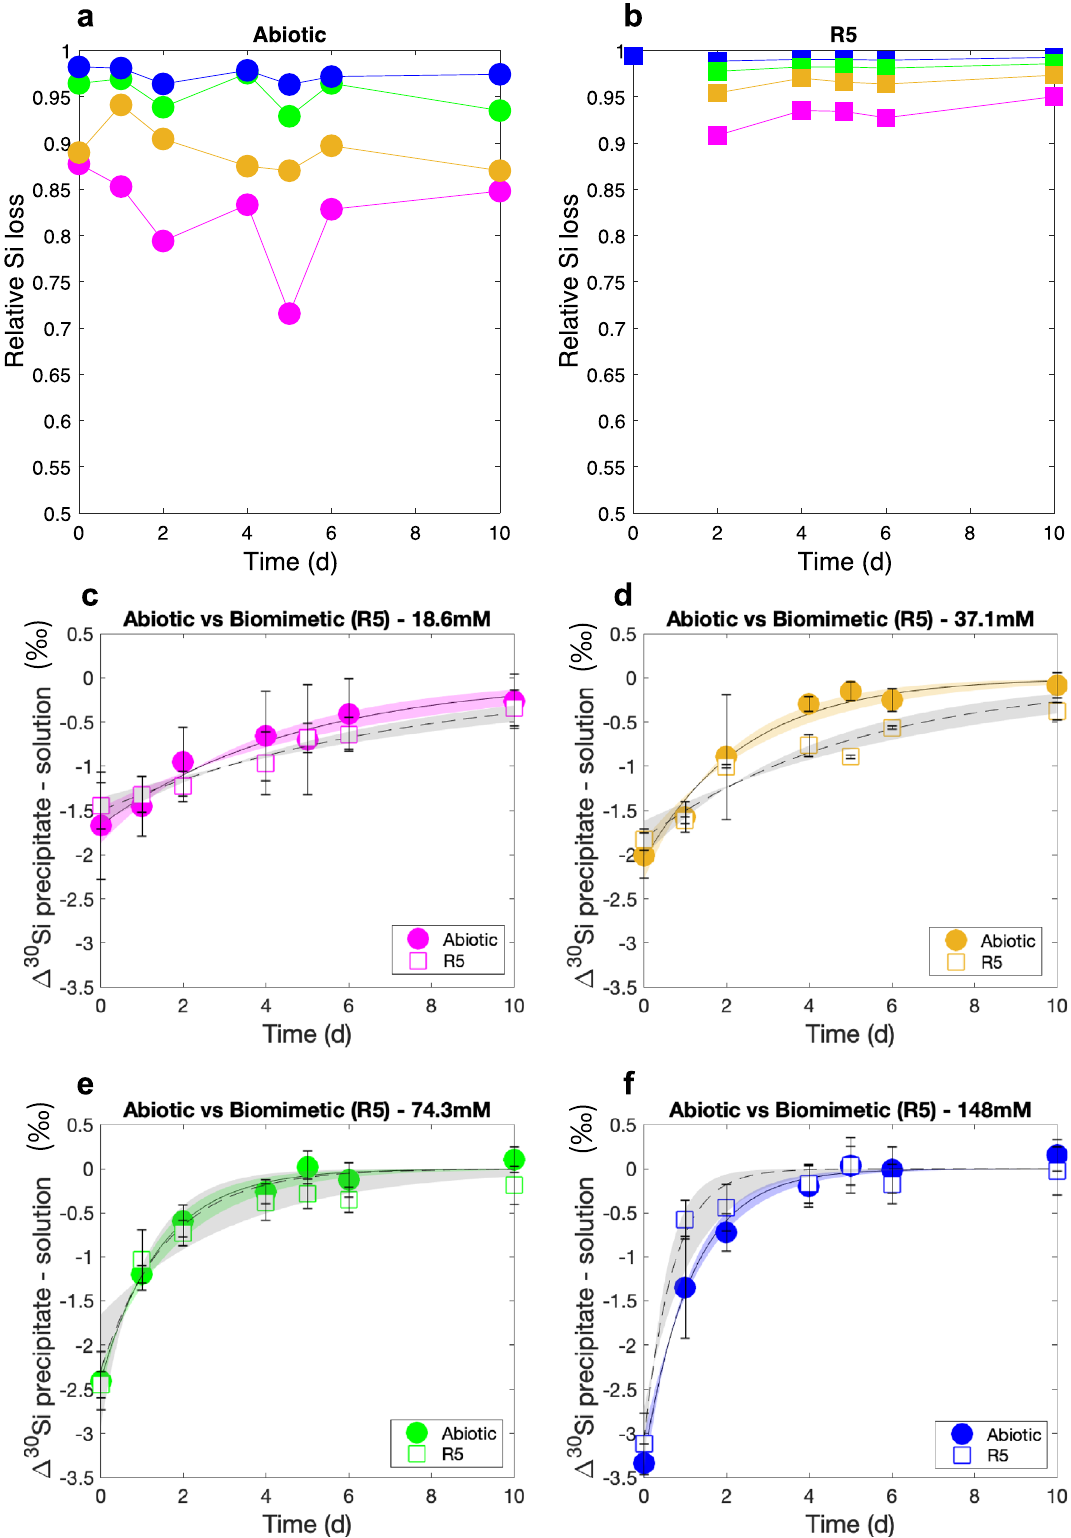
Figure 4. ( a , b ) Relative Si loss and ( c – f ) Si isotopic fractionation ( (cid:31) 30 Si p-s ) as a function of time comparing the Abiotic (circles) and biomimetic (squares) experiment for initial dSi concentration of 18.6 mM (pink), 37.1 mM (orange), 74.3 mM (green) and 148 mM (blue). Solid and dashed lines show the best fit (f(x)=a exp(− bx)) with the 95% confidence bounds for the abiotic (coloured) and biomimetic (grey) experiments, respectively. The best fit equations are presented in Table 1. δ 30 Si values are presented in Supplementary Tables S5 and